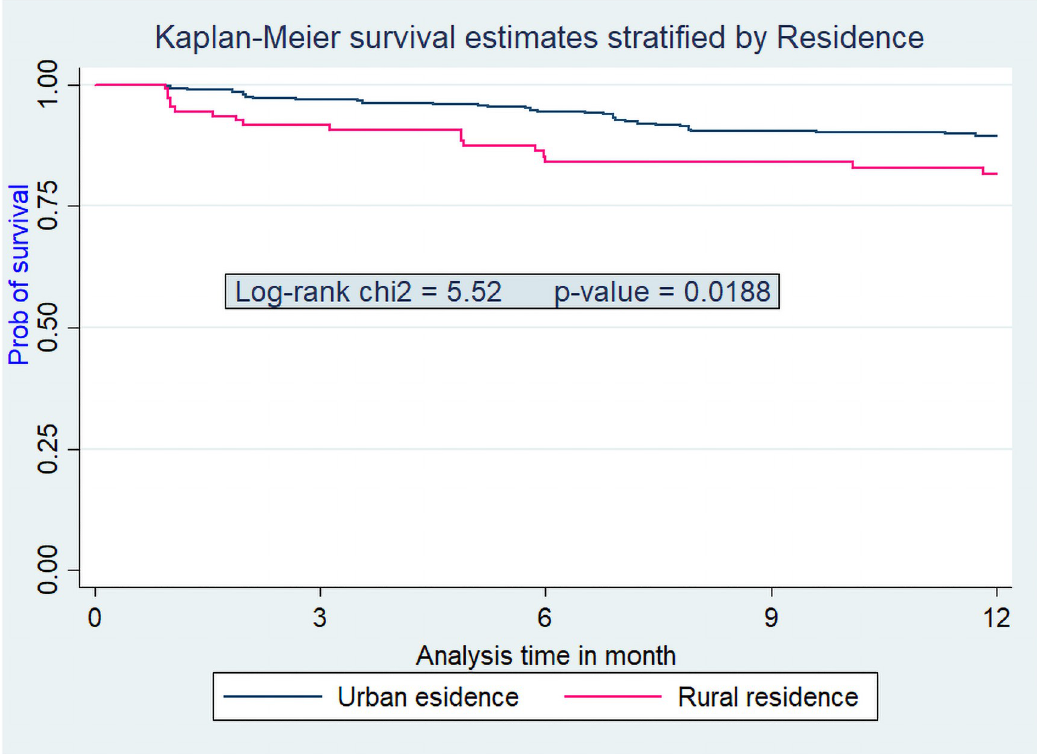
Fig 2. Kaplan Meier survival curve from ART initiation to death within one year stratified by residence among adults on ART at Debre-Markos Referral Hospital from Jan 1, 2014, to Dec 31,